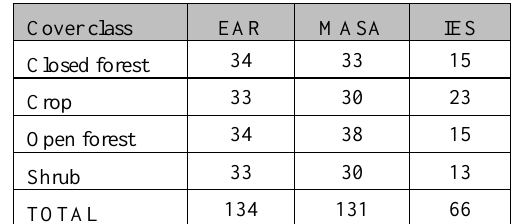
Table 2. Number of endmembers in a cover class for each